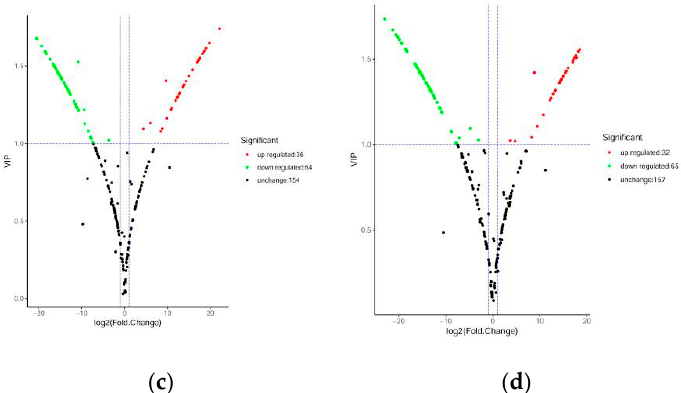
Figure 4. Volcanic plots of differential metabolites. ( a ) DHP versus BZH; ( b ) DHP versus TC; ( c ) DHP versus HZY; ( d ) DHP versus YCC. Each point in the volcanic plot represents a metabolite, the abscissa represents the logarithm of the quantitative difference multiples of a metabolite in two samples, and the ordinate represents the variable importance in project (VIP) value. The larger the abscissa absolute value is, the more significant the differential expression is, and the more reliable the screened differential expression metabolites are. The green dots in the figure represent down-regulated differentially expressed metabolites, the red dots represent up-regulated differentially expressed metabolites, and the black dots represent metabolites detected but that are not significantly different. Kyoto Encyclopedia of Genes and Genomes (KEGG) database (Supplementary Table S3). The